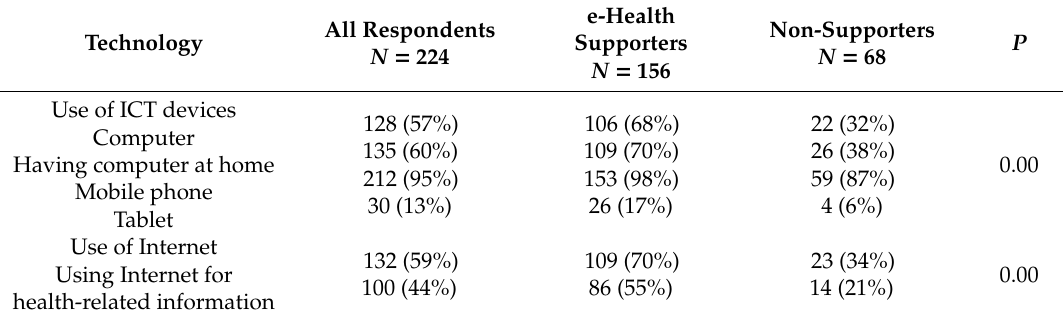
Table 4. Use of the information and communication technology (ICT) devices and the Internet among the